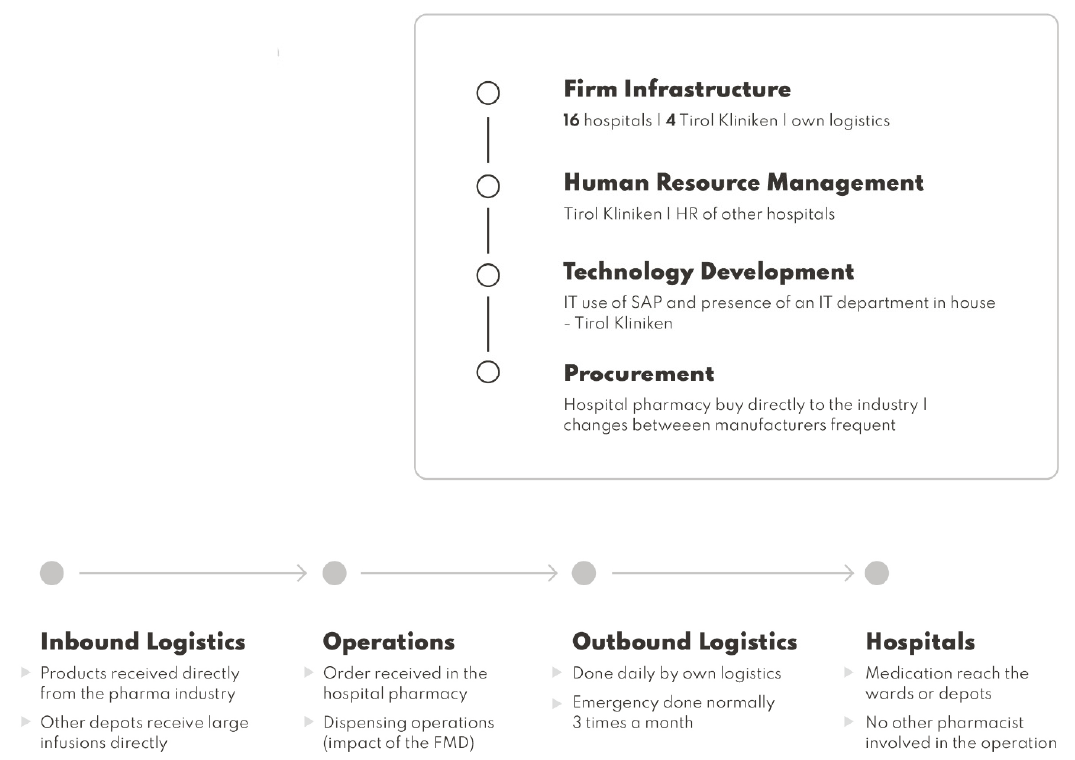
Figure 1. Porter’s value chain analysis of the present supply chain of the case hospital.